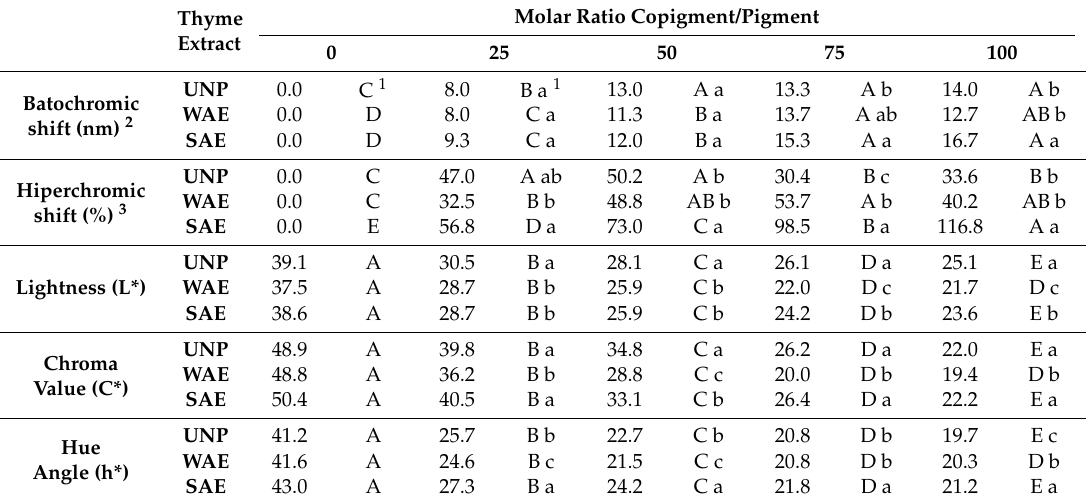
Effect of modified thyme extracts on the spectroscopic characteristics of strawberry ( Fragaria ananassa ) juice systems. Thyme